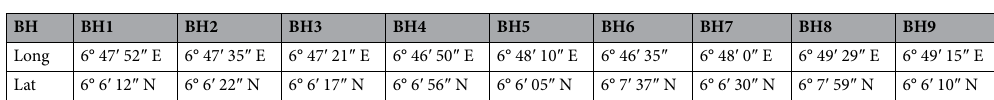
Table 1. GPS data for the geolocation of the boreholes sampled used for the correlation with the VES data.